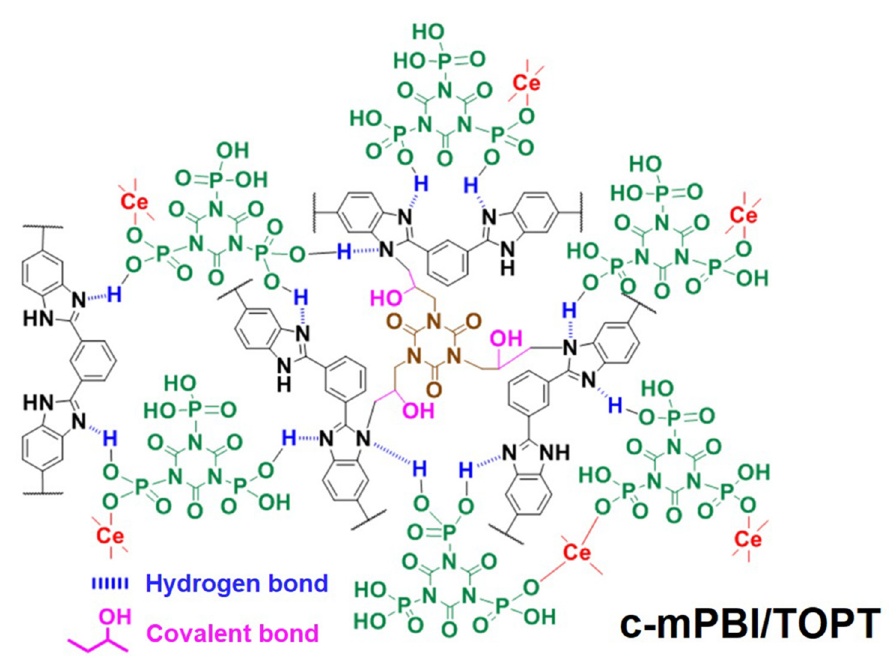
Figure 5. Chemical structure of c-mPBI/CeTOPT composite membrane from Ref. [92].